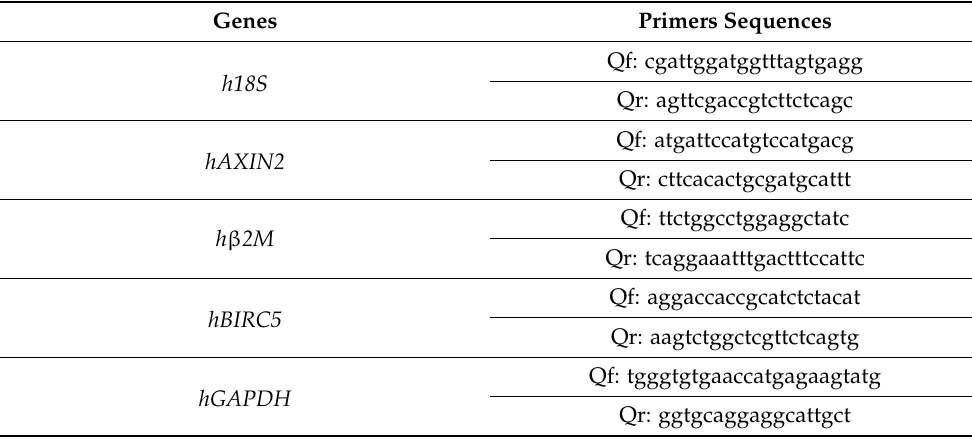
Table 2. Primers used for qPCR